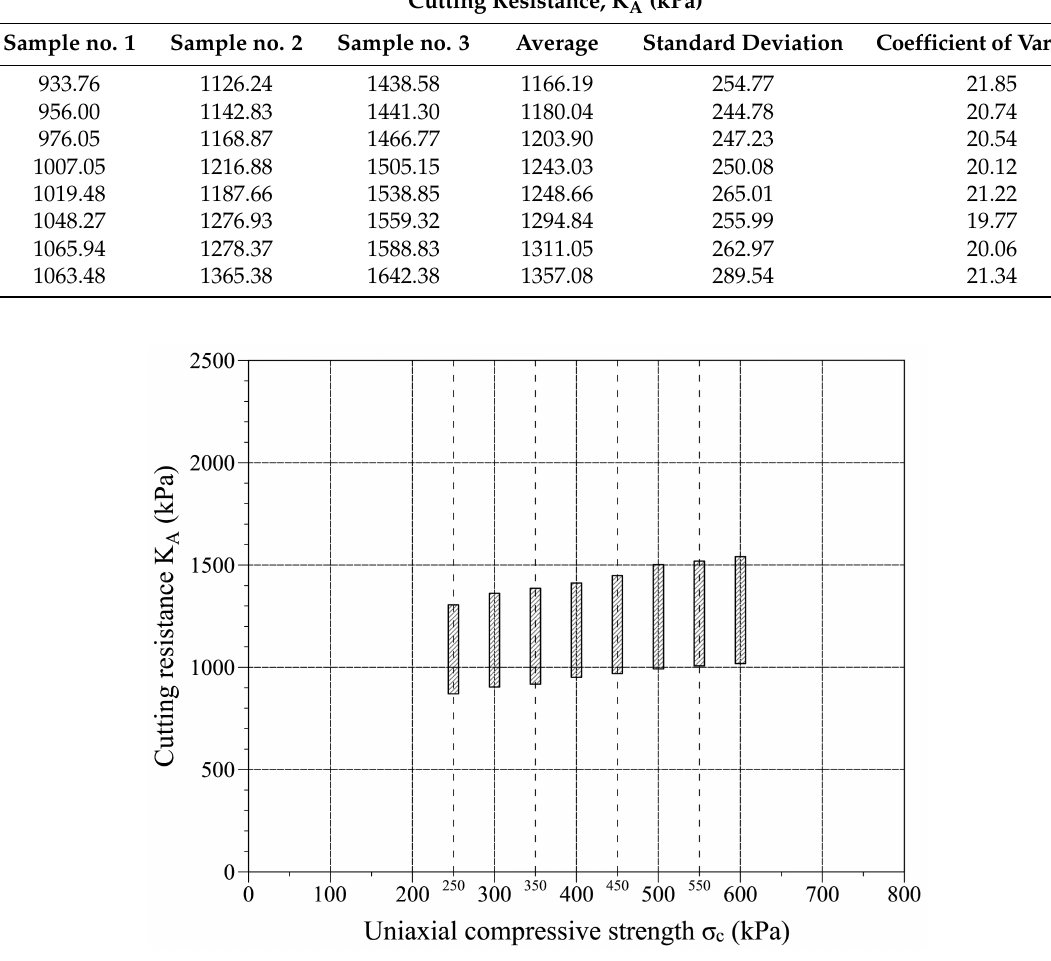
Figure 18. Cutting resistance test results’ intervals for all defined confining pressures, σ 3.